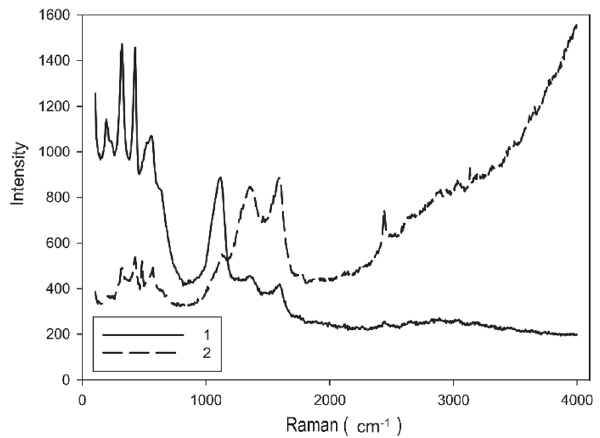
Fig. 3 RS results for a sample of solids obtained at 600 (cid:3) C